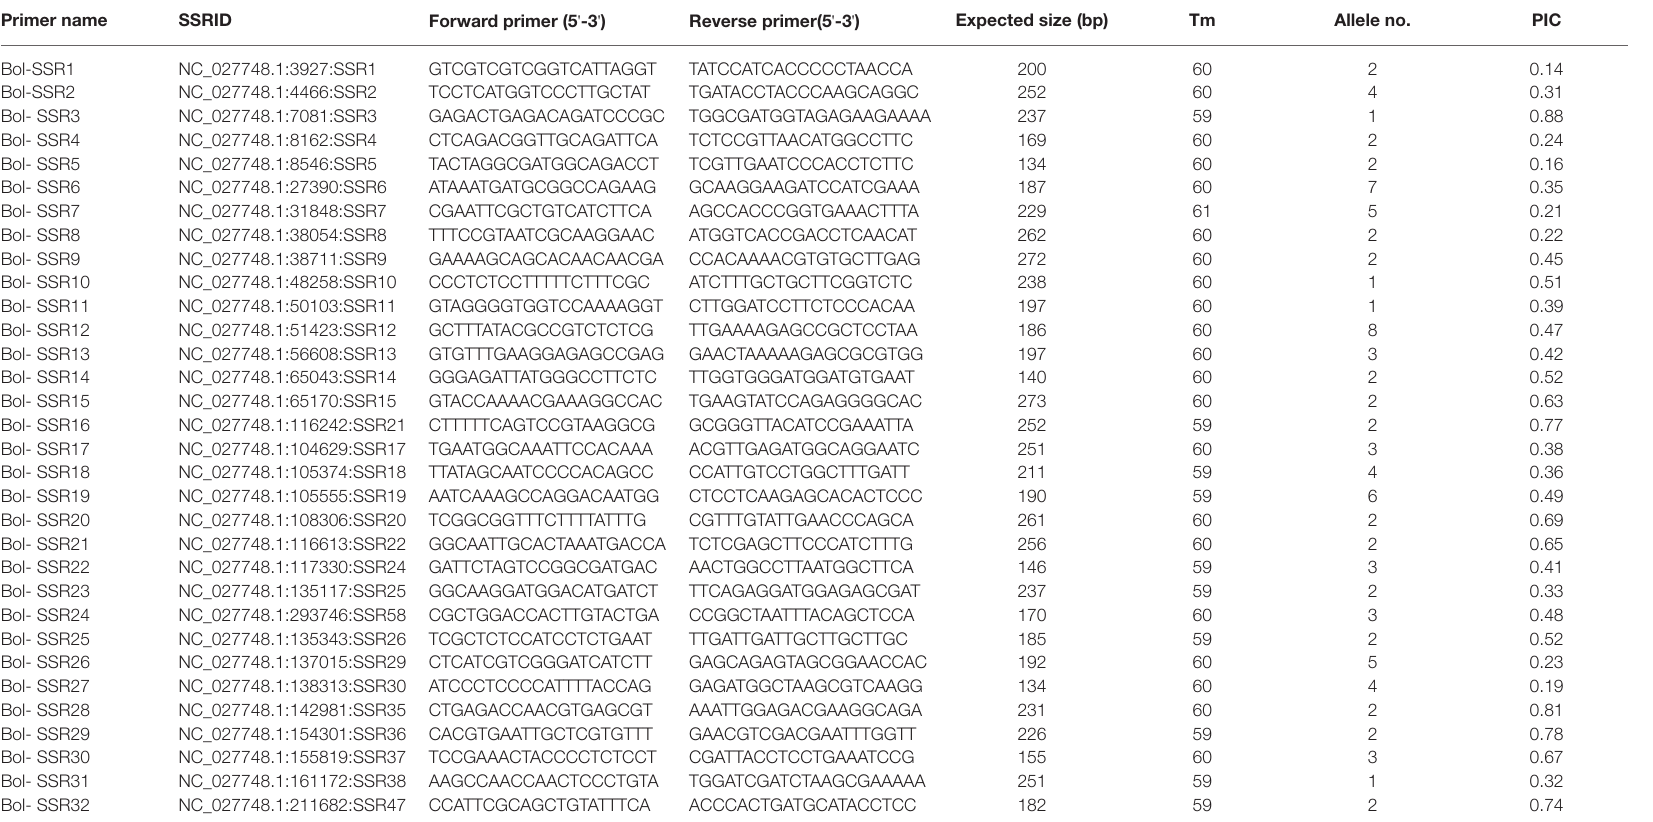
TABLE 5 | Genetic diversity analysis with SSR markers developed in